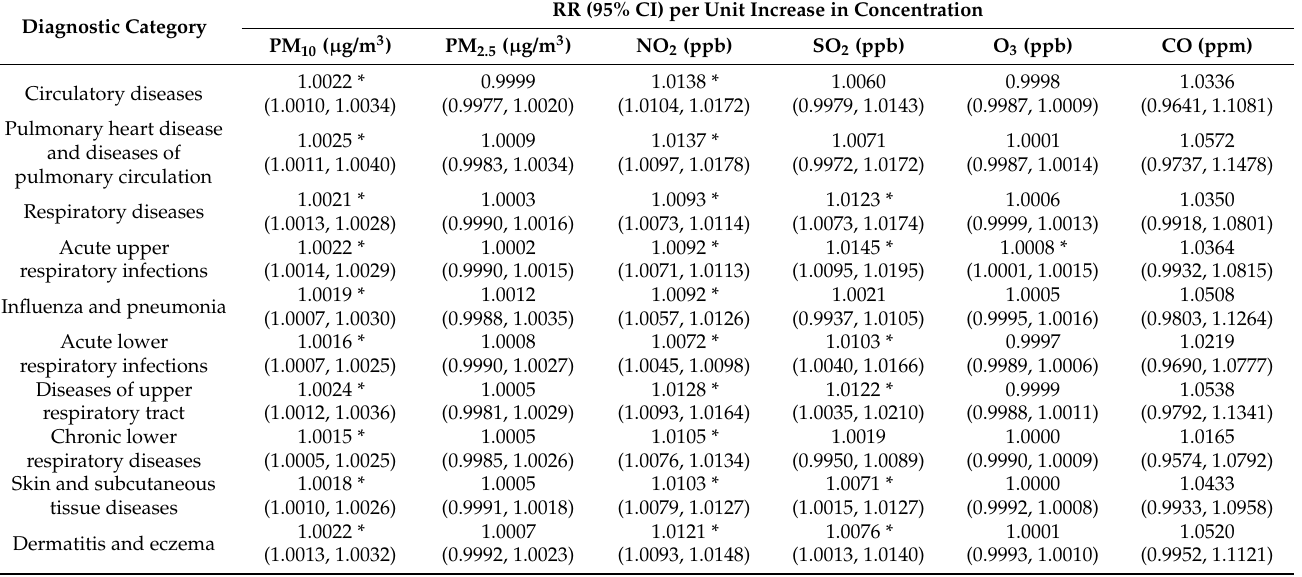
Table 4. Associations between unit increase in pollutant concentrations and outpatient department visits for specific